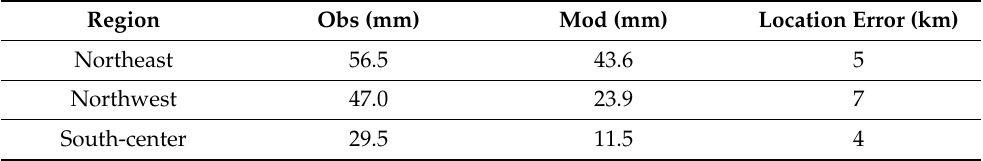
Figure 7. The horizontal distribution of the 3 h accumulated rainfall (mm) for the period of 1500–1800 LST for ( a ) observation and ( b ) CNTL simulation. E and D in ( a ) represent Eunpyeong and Dongdaemun stations, respectively. Boxes in ( b ) indicate regions in Table 4, and black dots indicate observation stations with maximum rainfall in each region. Table 4. Maximum 3 h accumulated rainfall for the period of 1500–1800 LST in each region (Figure 7b) in the analysis domain for observation and CNTL simulation and location error between model and